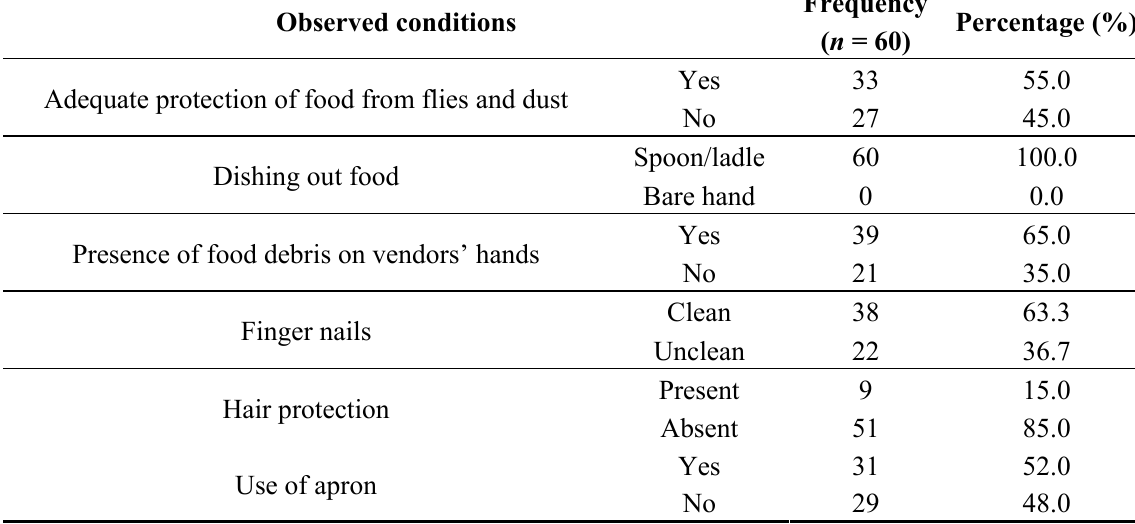
Table 4. Hygienic practices observed by food